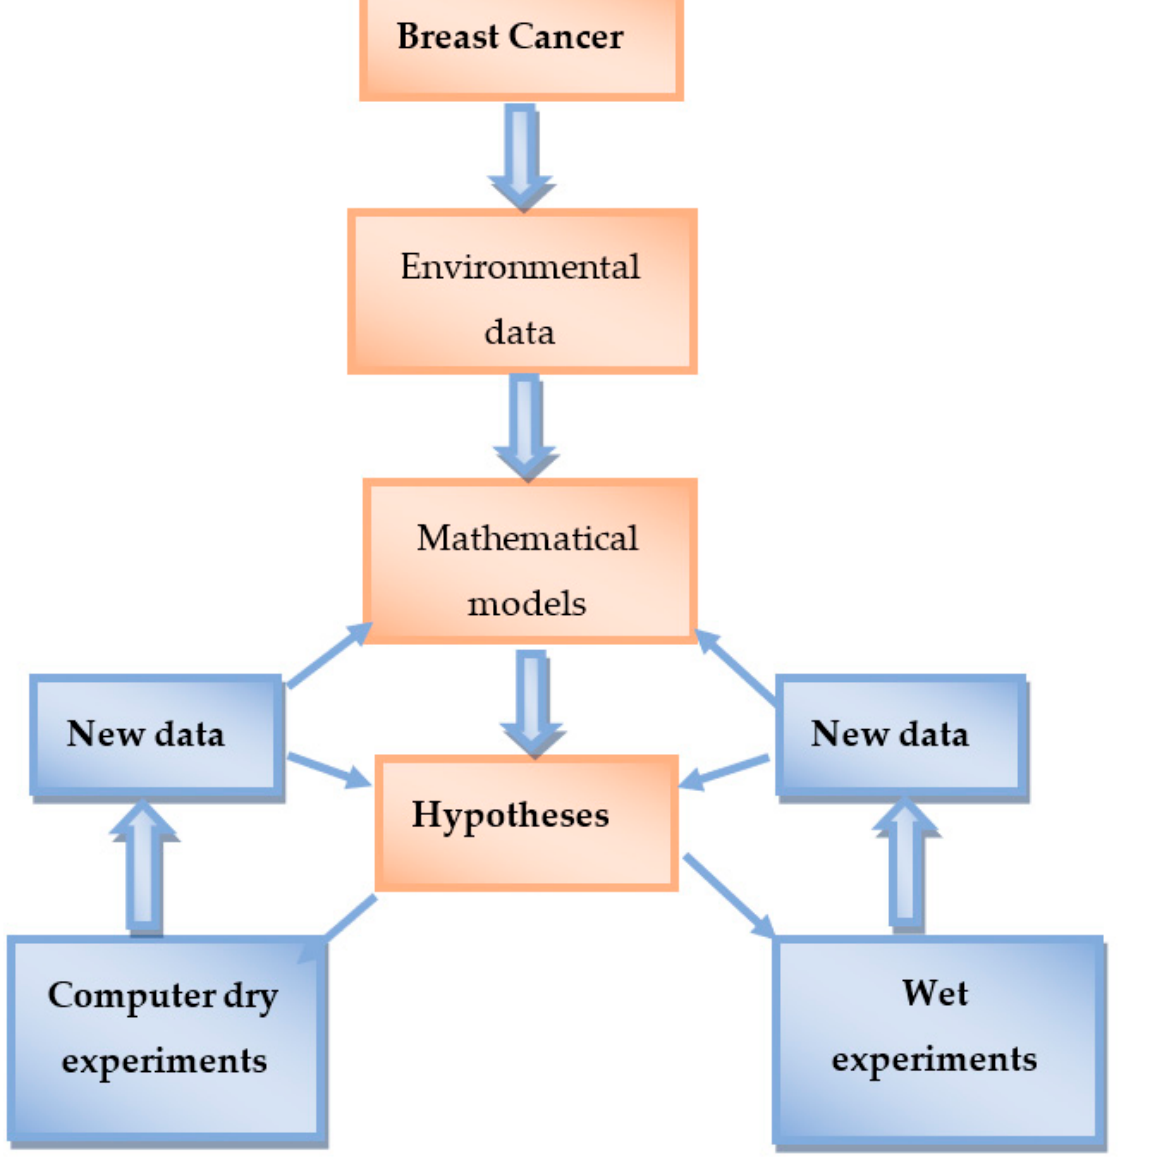
Figure 1. Mathematical models to generate and refine hypotheses of breast cancer.